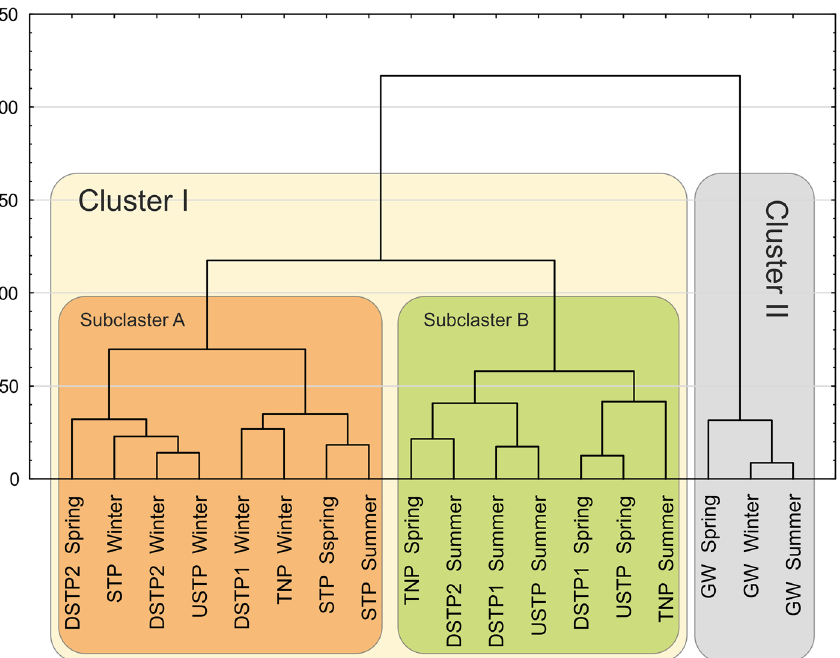
treatment plant; STP—sewage treatment plant; DSTP1—c.a. 3 km downstream of the STP; DSTP2—c.a. 7 km downstream of the STP (for detailed description, please see caption of Fig.